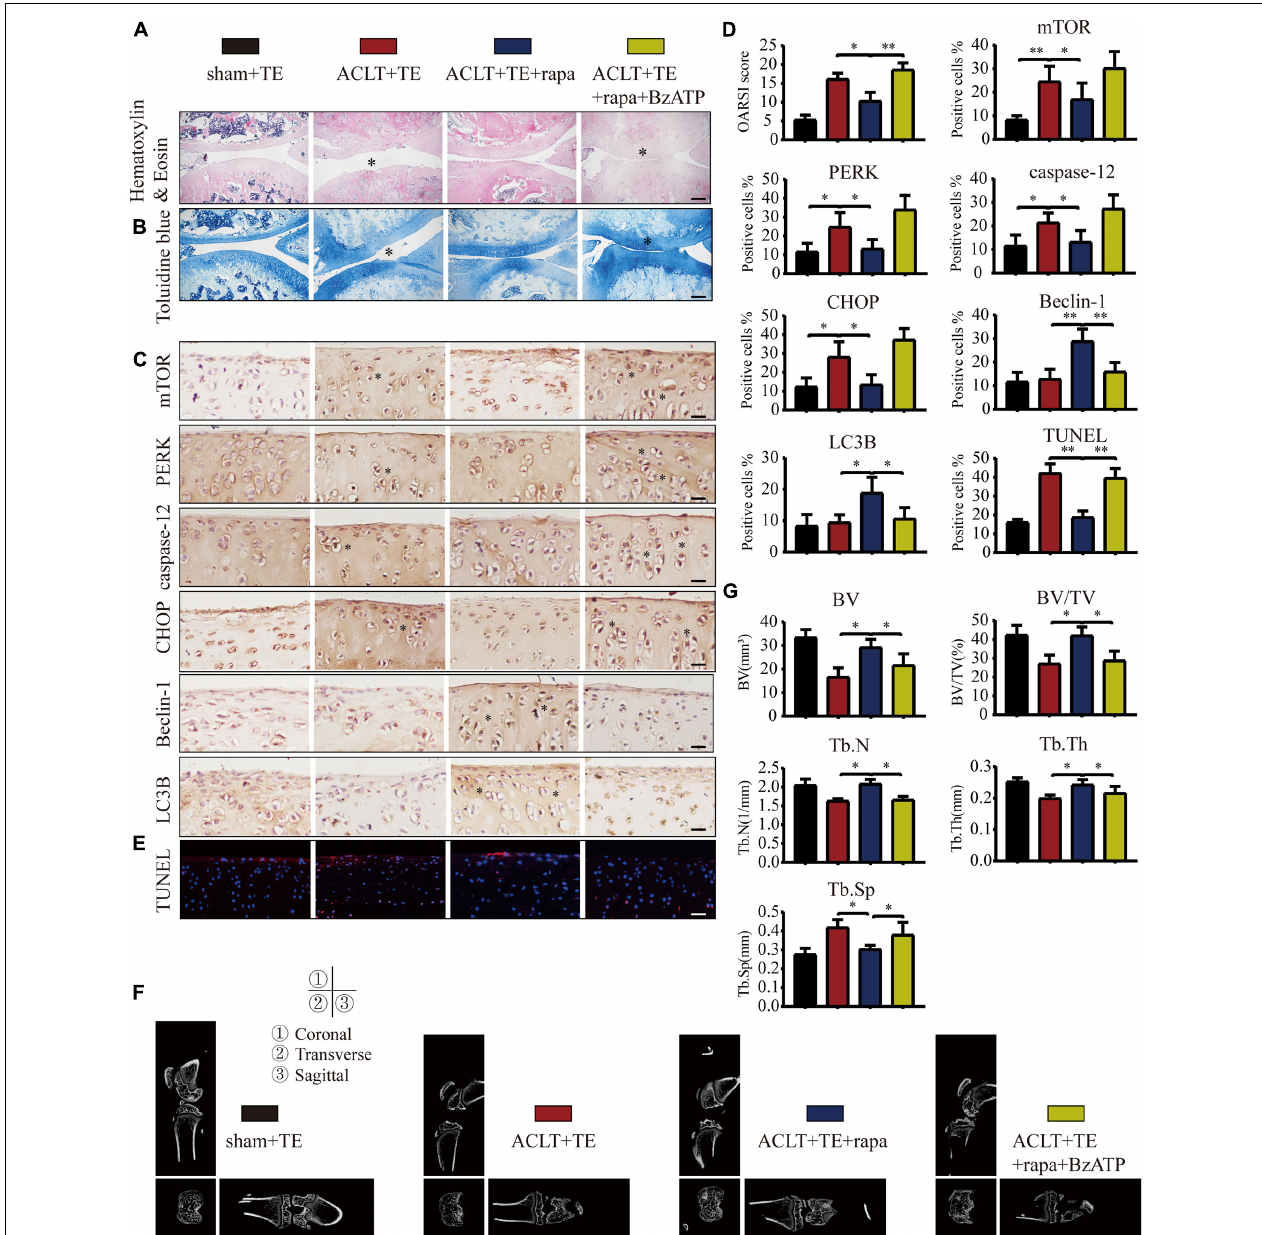
FIGURE 8 | Inhibition of mTOR promotes autophagy, decreases apoptosis, and reduces cartilage loss. The sagittal sections of knee joints were stained with H&E (A) and TB (B) at the 8-week time point (scale bar: 500 µ m). The degree of cartilage loss and matrix degradation was quantified using the OARSI scoring system; data are presented on the right. (C,D) IHC staining and quantification of mTOR, PERK, caspase-12, CHOP, LC3B, and Beclin-1 were performed to observe changes in the expression levels of these markers after intra-articular injections of rapamycin and Bz-ATP (scale bar: 200 µ m). (E) TUNEL staining was performed to detect the number of apoptotic chondrocytes in each group (scale bar: 200 µ m). (F) Micro-CT was used to evaluate the knee joints in each group and to obtain the imaging data of the tibial plateau and subchondral bone (scale = 1 mm). (G) Quantification of micro-CT bone-related parameters, including BV, BV/TV, Tb.N, Tb.Th, and Tb.Sp. The asterisk in the HE and TB staining images represents the cartilage damage site, and the asterisk in the histochemical images represents the positively stained cells. Data are expressed as means ± standard deviations of at least three independent experiments. ∗ p < 0.05, ∗∗ p <